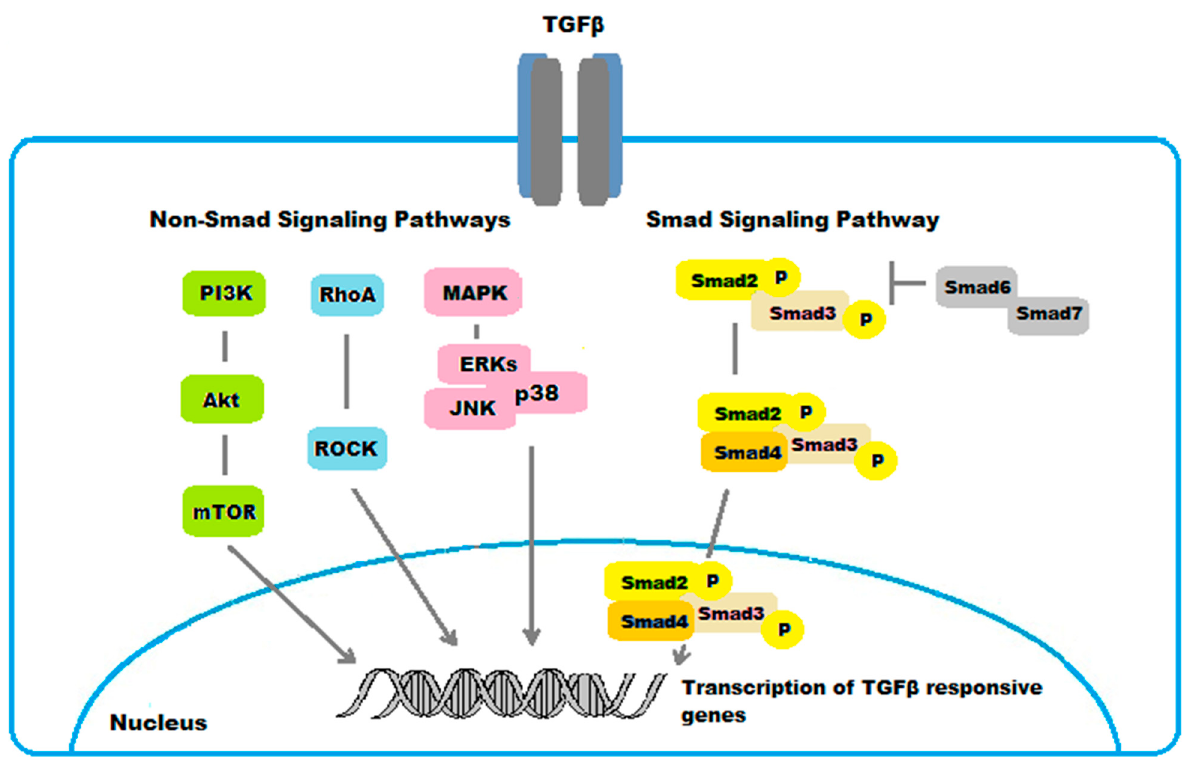
Figure 5. Schematic representation of TGF β /Smad- and non-Smad-regulated pathways in ocular fibrogenic disorders.